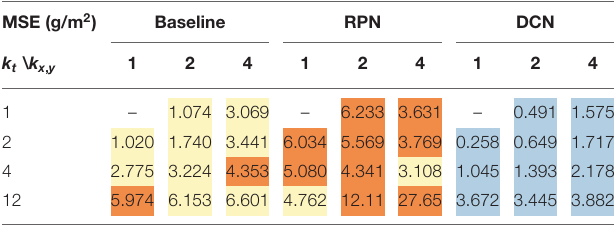
TABLE 2 | Precipitation (g/m 2 ) downscaling mean-squared errors (MSE), coloring the best ( • ), intermediate ( • ) and worst ( • ) result. MSE (g/m 2